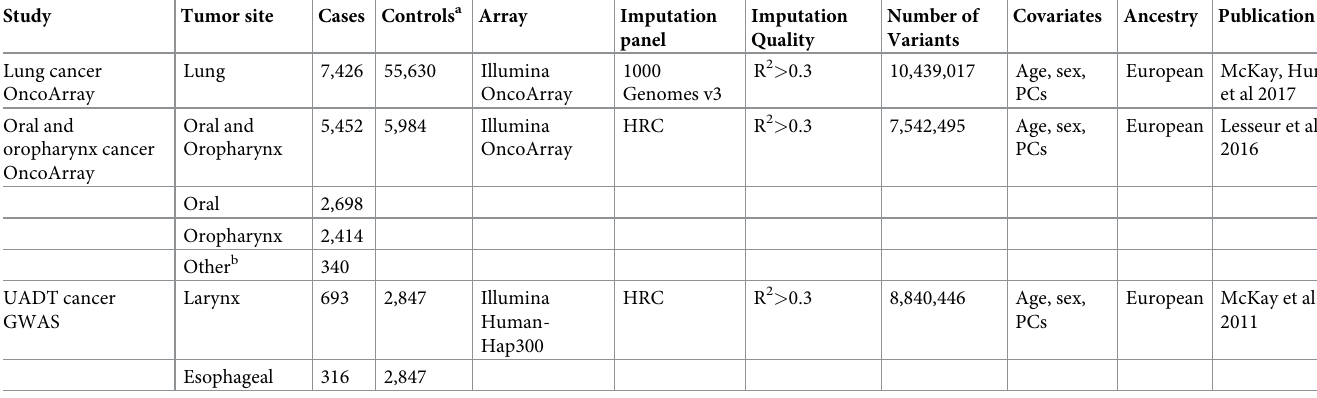
Table 1. Summary of studies included in the aerodigestive SqCC meta-analysis.